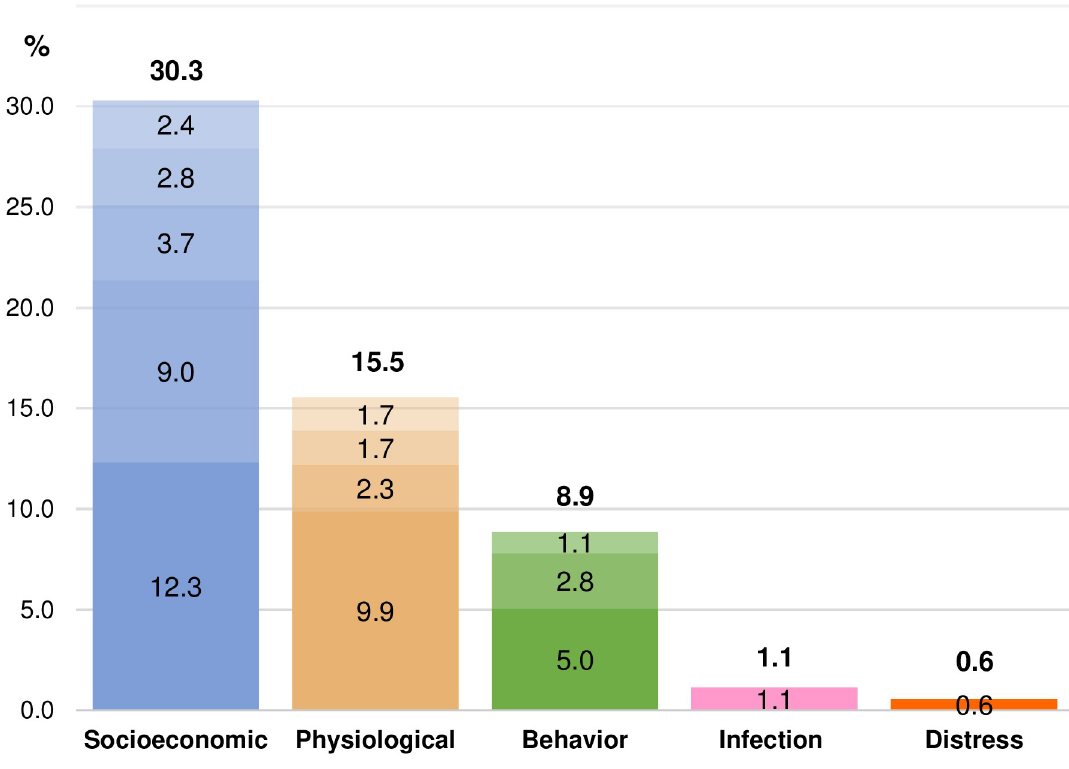
Fig 5. The proportion of HAZ-score lost associated with parental distress and other specific